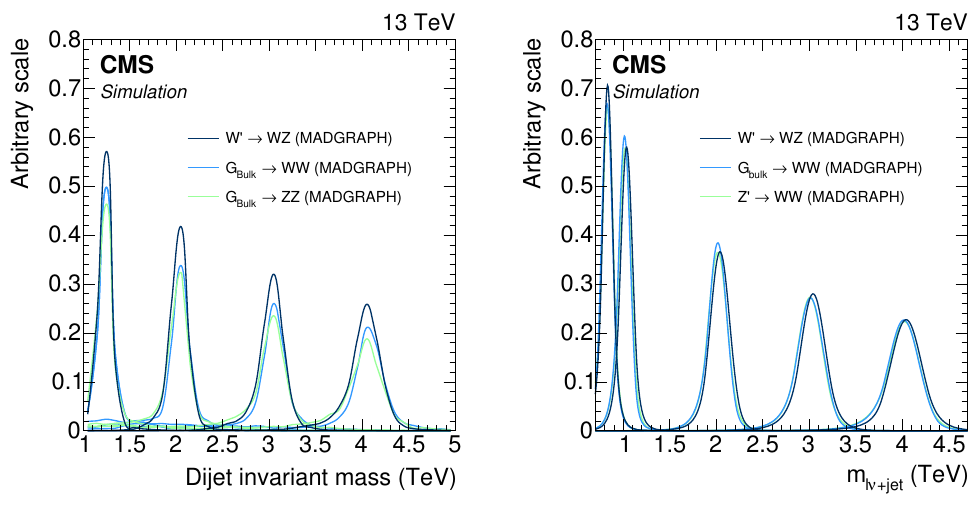
Figure 5 . Dijet invariant mass (left) and m ‘(cid:23) +jet (right) distributions expected for di(cid:11)erent signal mass